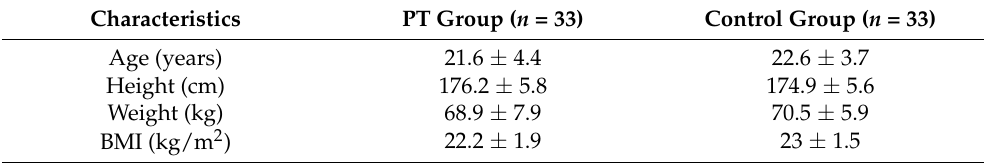
Table 1. Participants’